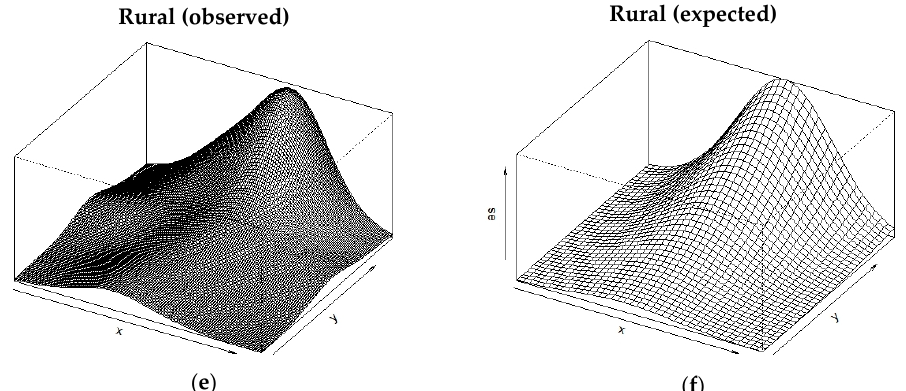
Figure 4. Comparison between the observed ( left ) and the expected ( right ) spatial pattern under model (7) of accommodation establishments in Extremadura ( a ) Hotels (observed) ( b ) Hotels (expected) ( c ) Extra-Hotels (observed) ( d ) Extra-Hotels (expected) ( e ) Rural (observed) ( f ) Rural (expected).